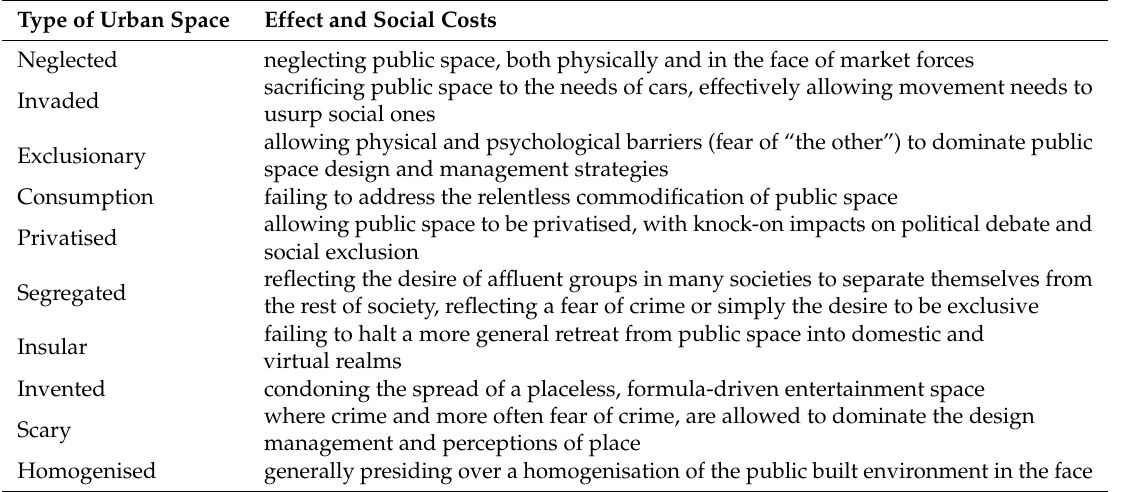
Table 1. Types of urban space and their effect and social costs due to poorly designed UGBS (urban green and blue space)